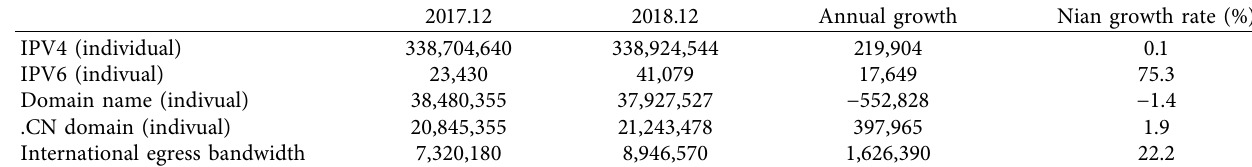
Table 1: Comparison of basic Internet resources in